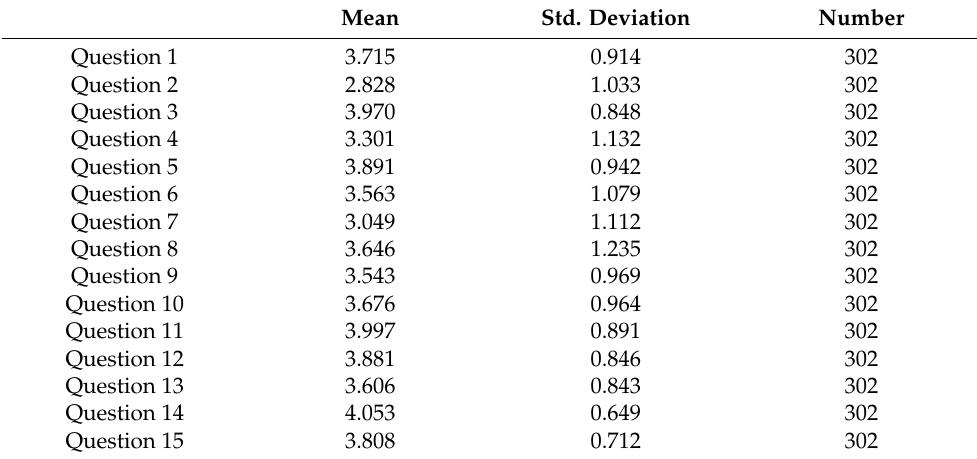
Table 4. Descriptive statistics for survey questions.